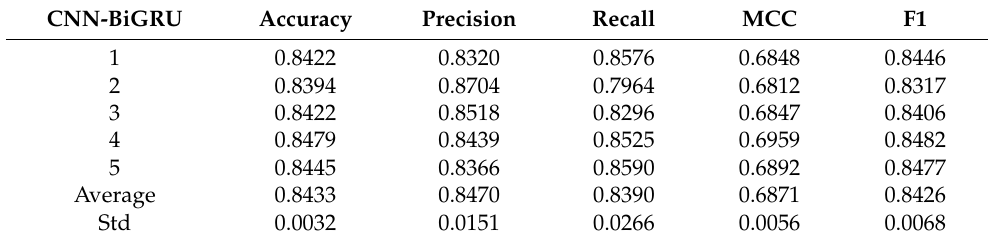
Table 4. Results of repeating the experiment five times for the CNN-BiGRU model.